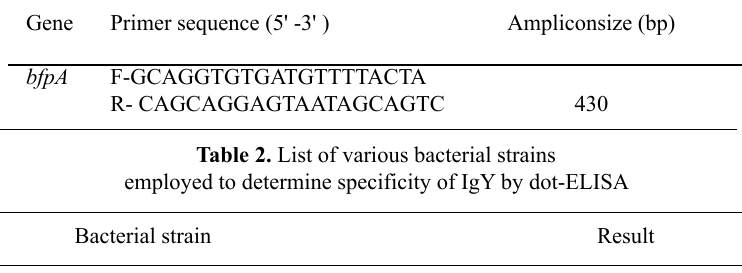
table 1. Primer sequence for the detection of EPEC